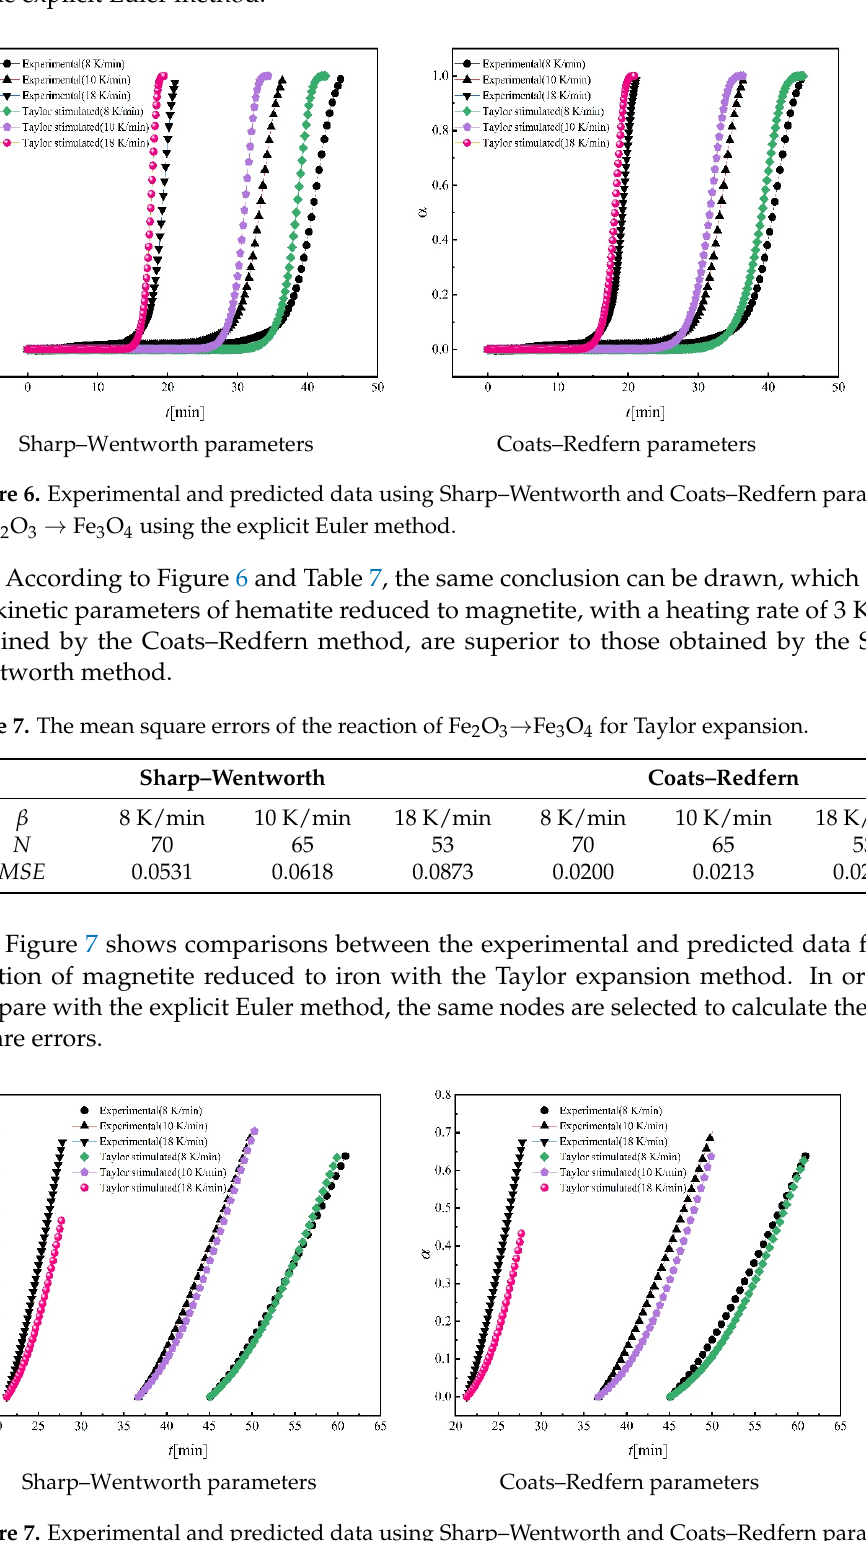
Figure 7. Experimental and predicted data using Sharp–Wentworth and Coats–Redfern parameters of Fe 3 O 4 → Fe by Taylor expansion.